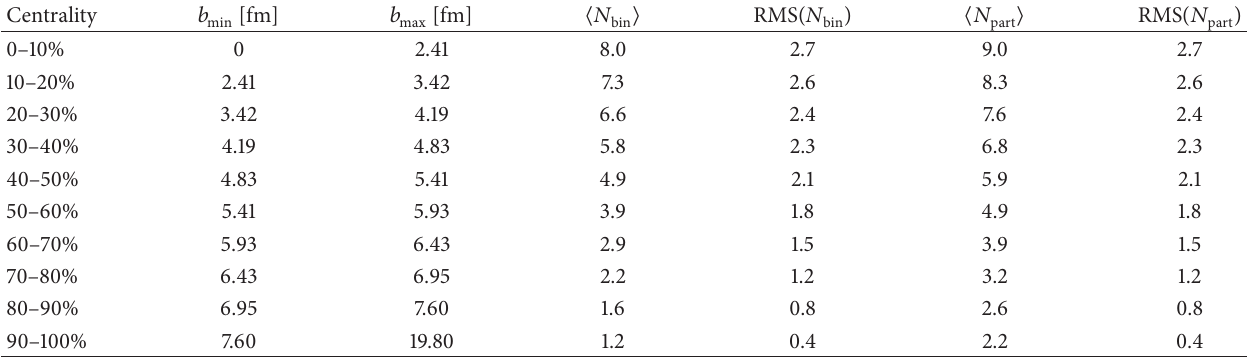
Table 1: Average number of participants ⟨𝑁 part ⟩ and binary collisions ⟨𝑁 bin ⟩ in 𝑝 -Pb collisions at √𝑠 𝑁𝑁 = 115 GeV for centrality classes defined as percentiles of the hadronic cross section. The mean values and the RMS are obtained with a Glauber Monte Carlo calculation.